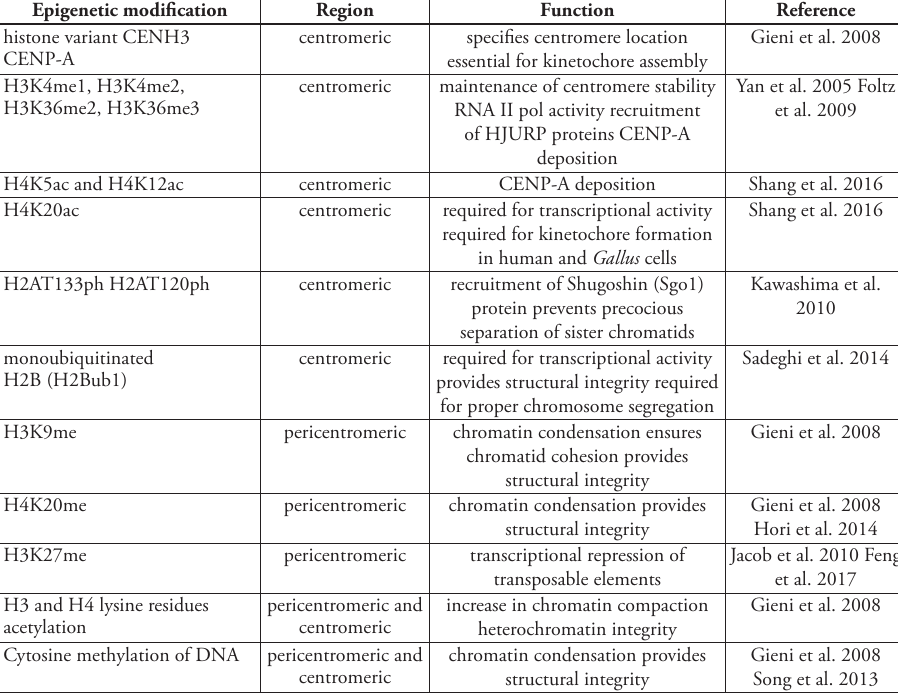
Table 1. Epigenetic modifications of centromeric regions and their functions in plants and animals. Epigenetic